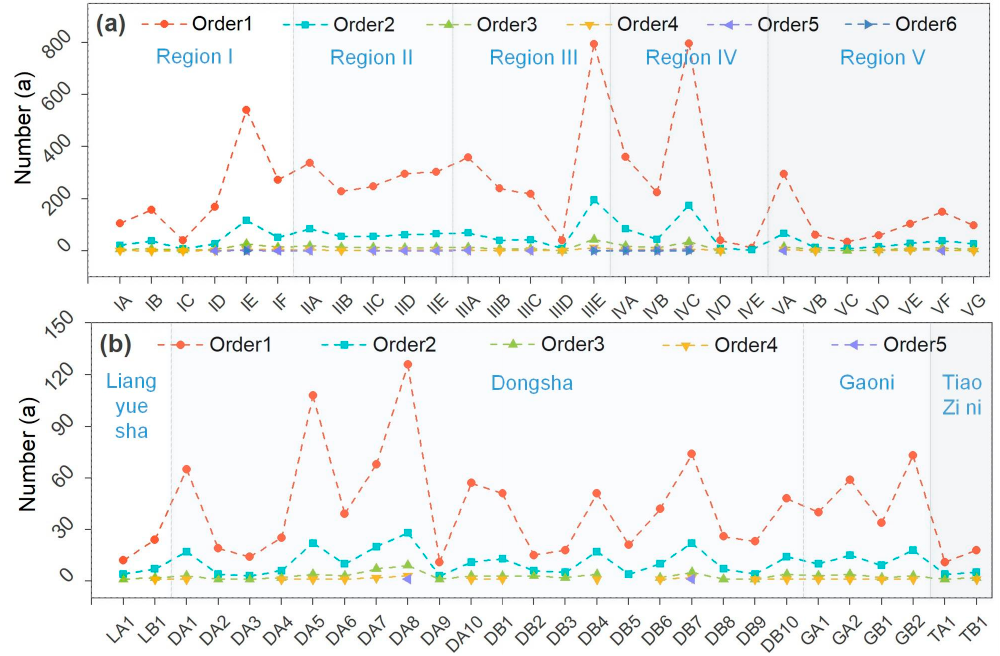
Figure 12. Numbers of coastal ( a ) and offshore ( b ) tidal creeks of different order in 56 tidal basins.